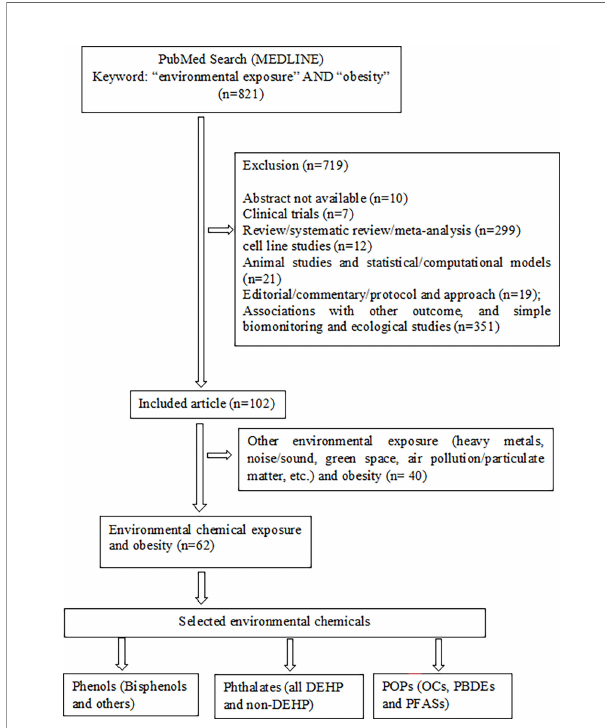
FIGURE 2 | Schematic diagram of study selection. *Cell line studies, animal/ rodent/drosophila studies, investigation of other associations (e.g., growth, metabolic syndrome, fatty liver disease, diabetes, cardiometabolic risk, in fl ammation, polycystic ovary syndrome, prostate cancer, food intake, semen quality, puberty), ecological studies, and or simple biomonitoring studies.